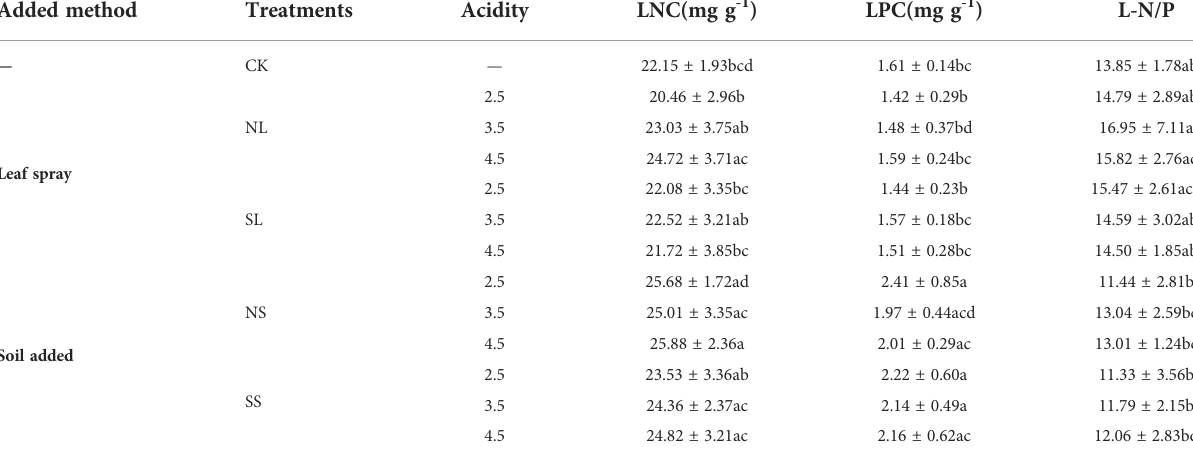
TABLE 2 Effects of simulated acid deposition on characteristics of leaf N and P of Acer catalpifolium . Added